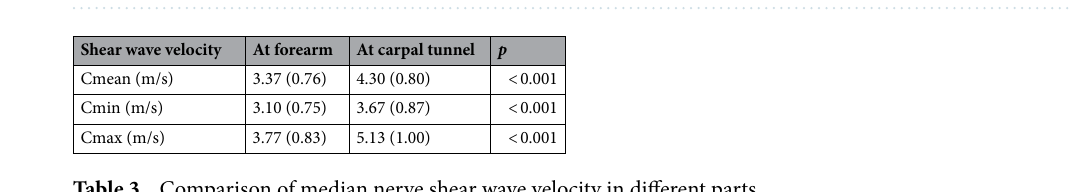
Figure 3. In the relaxed position, the shear wave velocity of the right median nerve at forearm ( a ) and at the carpal tunnel ( b ).